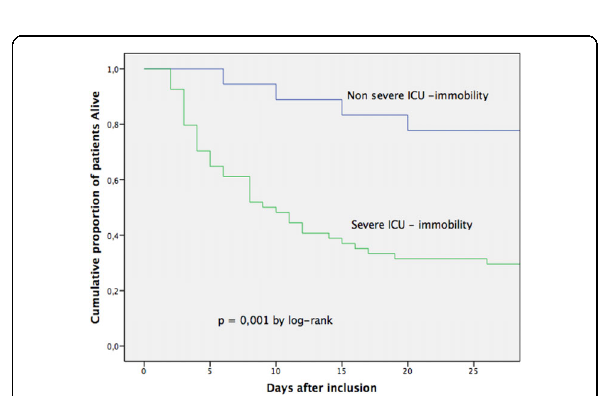
Fig. 4 (abstract 000926). See text for